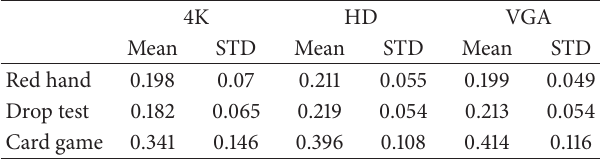
Table 1: Summary of test means and standard